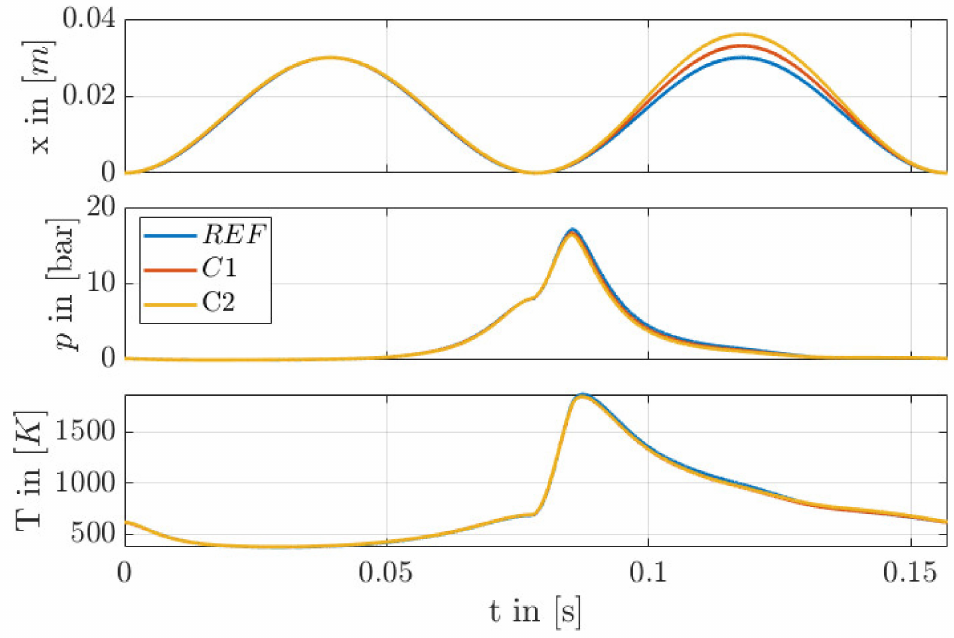
Figure 25. Comparison of trajectories REF, C1 and C2 related to the energy conversion of the internal combustion engine: illustration of the stroke, cylinder pressure and temperature depending on